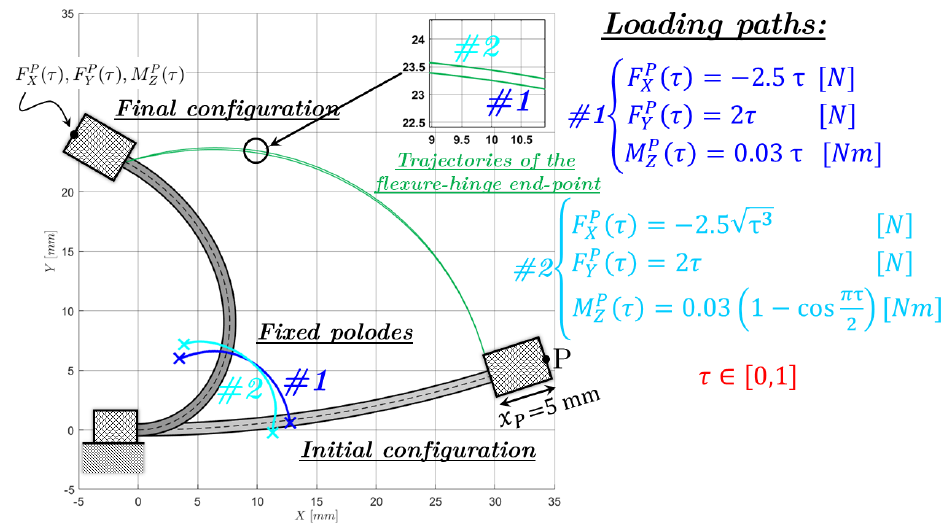
Figure 8. Flexure-hinge loaded by two loading paths with the same final loads but different rate-trends. initial positions of the c.i.r. do not coincide